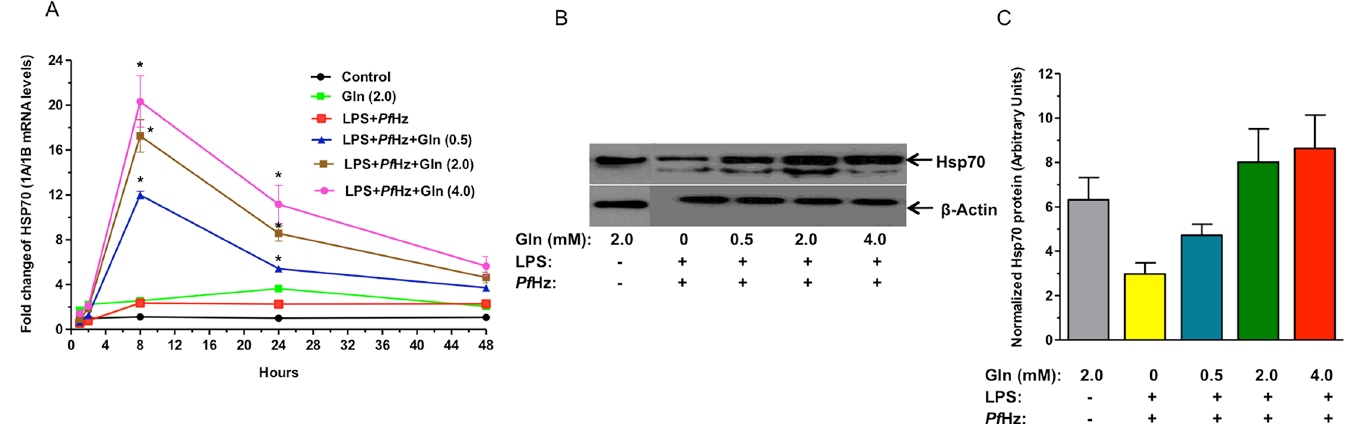
Figure 6. Effect of glutamine treatment on Pf Hz-mediated inhibition of HSP70. (A) Peripheral blood mononuclear cells (2.5 × 10 6 ) were incubated with LPS for 1 h prior to addition of Gln (0.5, 2.0 and 4.0 mM, pretreated 30 min prior to adding Pf Hz) for different time points. Total RNA was isolated and gene expression analysis by qRT-PCR was performed to quantify the HSP70 ( 1A + 1B ) transcripts, using TaqMan ® gene expression assays. β -actin was used as an endogenous control to normalize the data by the ΔΔ CT method. Data repre- sent average of individuals (n = 3) with each condition performed in triplicate (error bars represent SEM). * indicates P < 0.05 (one-way ANOVA) relative to LPS + Pf Hz treated cells. (B) Experiments performed as outlined in A showing the effect of Gln (0.5, 2.0 and 4.0 mM) on Pf Hz-mediated inhibition of Hsp70 assessed using immunoblotting at 24 h. (C) Densitometry analysis was performed to quantify inten- sity of expression. Data shown after normalizing Hsp70 relative to β -actin (n = 3); error bars represent